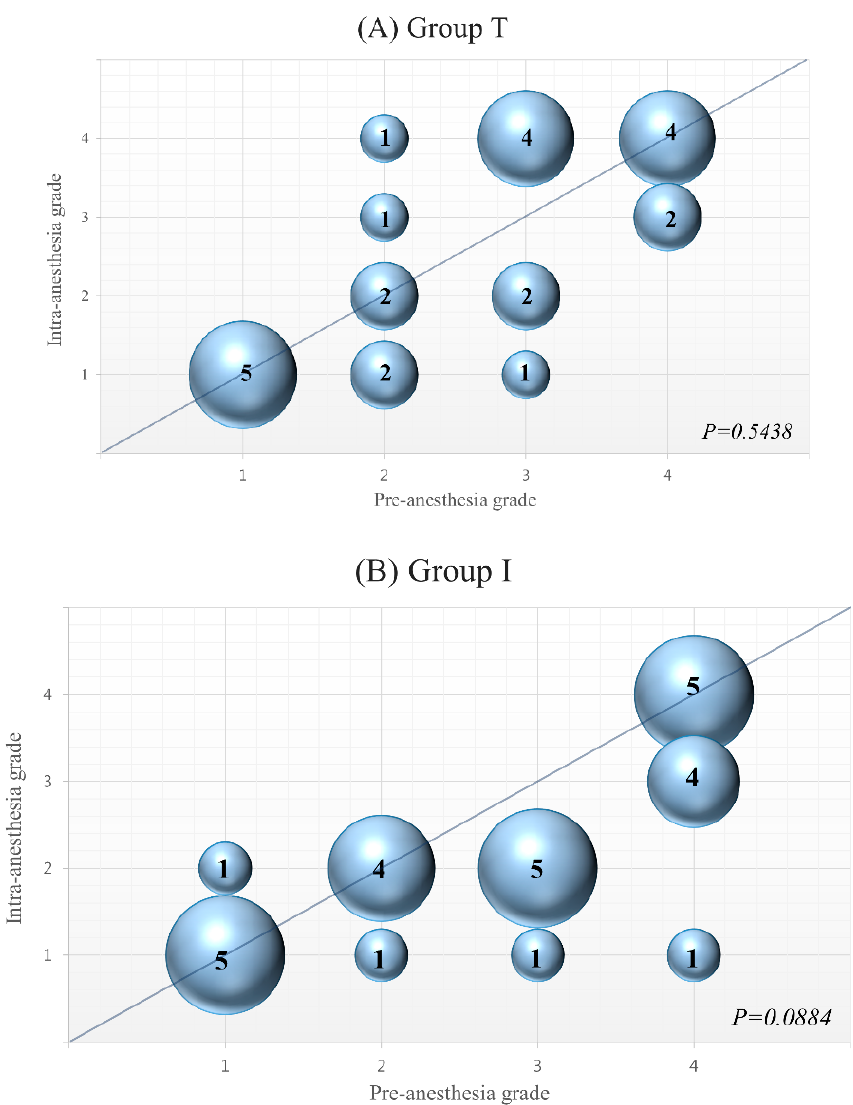
Figure 3. ( A , B ) Bubble plot. The TIVA group ( A ) maintained pre-anesthesia grade mitral regurgitation during anesthesia ( p = 0.5438). The grade of mitral regurgitation showed a tendency of reduction during anesthesia in the isoflurane group ( p = 0.0884) ( B ). Bubbles on the diagonal line indicate patients whose mitral regurgitation grade did not change during anesthesia. Bubbles under the diagonal line indicate patients whose MR grade decreased during anesthesia. Bubbles above the diagonal line indicate patients whose mitral regurgitation grade increased during anesthesia. X: Pre-anesthesia grade, Y: Intra-anesthesia grade.